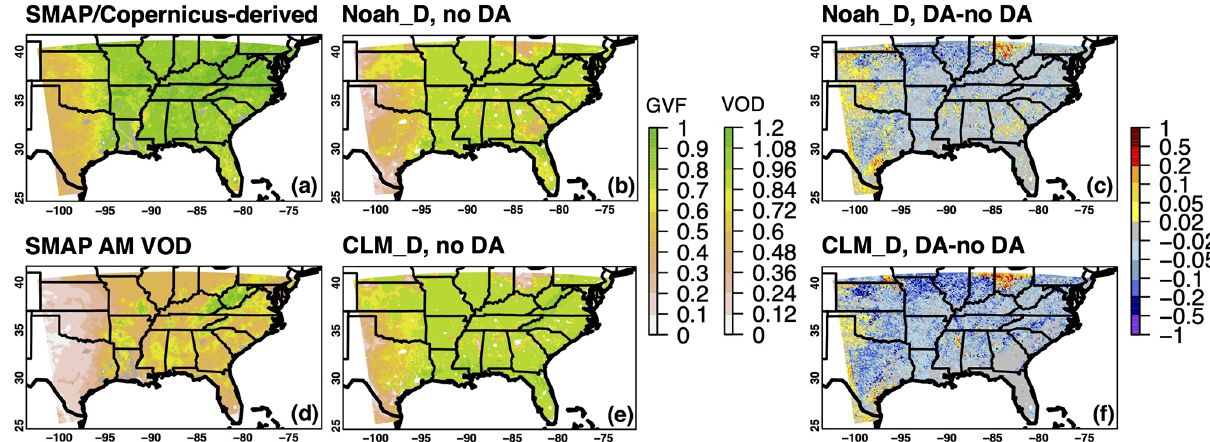
Figure 3. Period-mean (16–28 August 2016) green vegetation fraction (GVF) (a) derived from the Copernicus Global Land Service product and the SMAP morning-time (AM) vegetation optical depth (VOD) using the method described in Fig. S2 and (b, c, e, f) based on WRF- Chem calculations as well as their responses to the SMAP DA. The GVF results from the Noah_D and CLM_D cases are shown in (b) and (c) and (e) and (f) , respectively. Period-mean SMAP AM VOD is shown in (d) . In (a) and (d) , grey indicates missing data over terrestrial